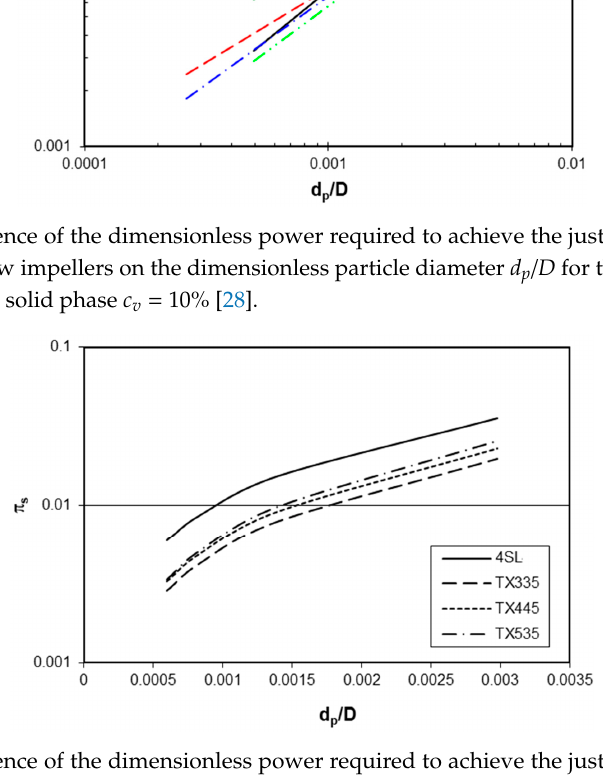
Figure 14. Comparison of the dimensionless power required to achieve the just-suspended state of particles for a standard pitched blade impeller and an axial flow impeller with large area folded blades [11,22]. A frequent application of mixing operations in industry is the mixing of suspensions with a high content of solid phase in a liquid. In equipment for the mixing of concentrated suspensions, it is often necessary to ensure, in addition to achieving the just-suspended state of the suspension particles, the sufficient homogeneity of the suspension in the agitated batch, which can be achieved using multistage axial flow impellers. From the point of view of the power of the multistage impellers required to achieve the just-suspended state of the particles, or required to keep the particles in this state, the most advantageous appear to be multistage impellers with the largest distance between the impellers, i.e., H 3 / d = 1.25, which corresponds to the conclusions given in Section 2.5. At the same time, the power of these multistage impellers does not depend on the number of their blades [35]. 0.001 0.01